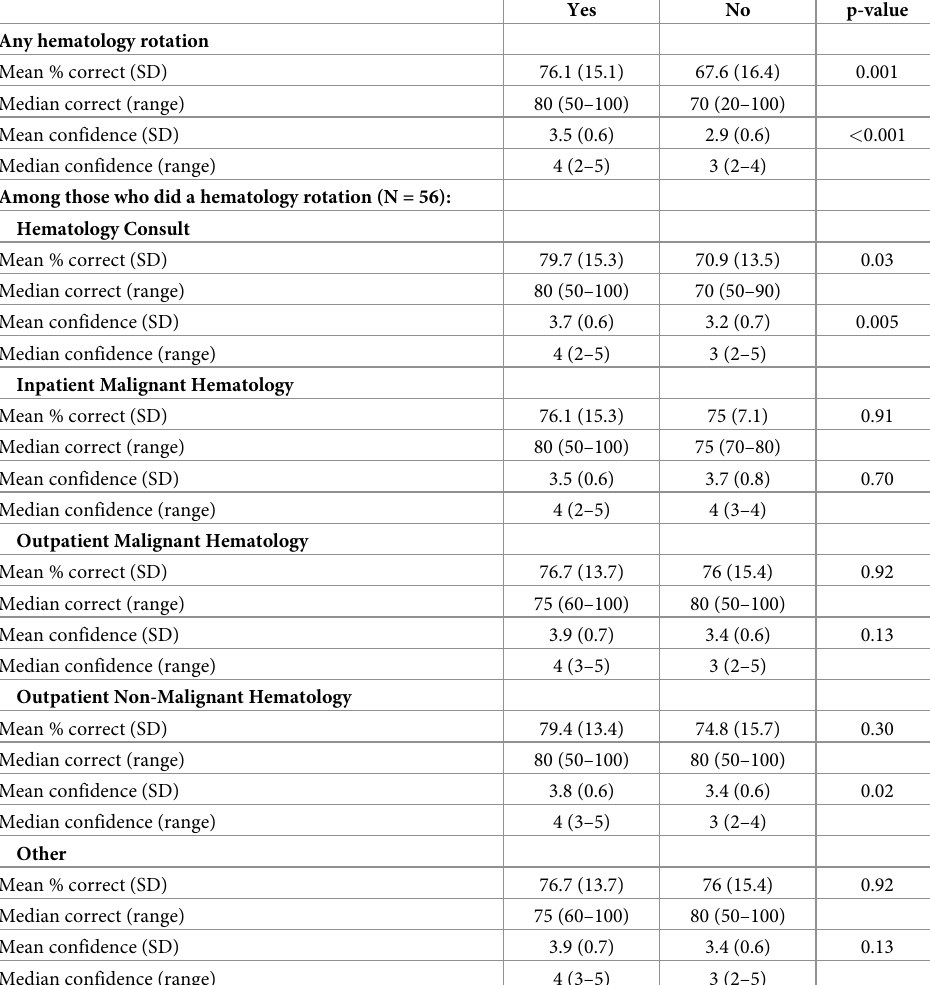
Table 3. Results based on hematology rotation